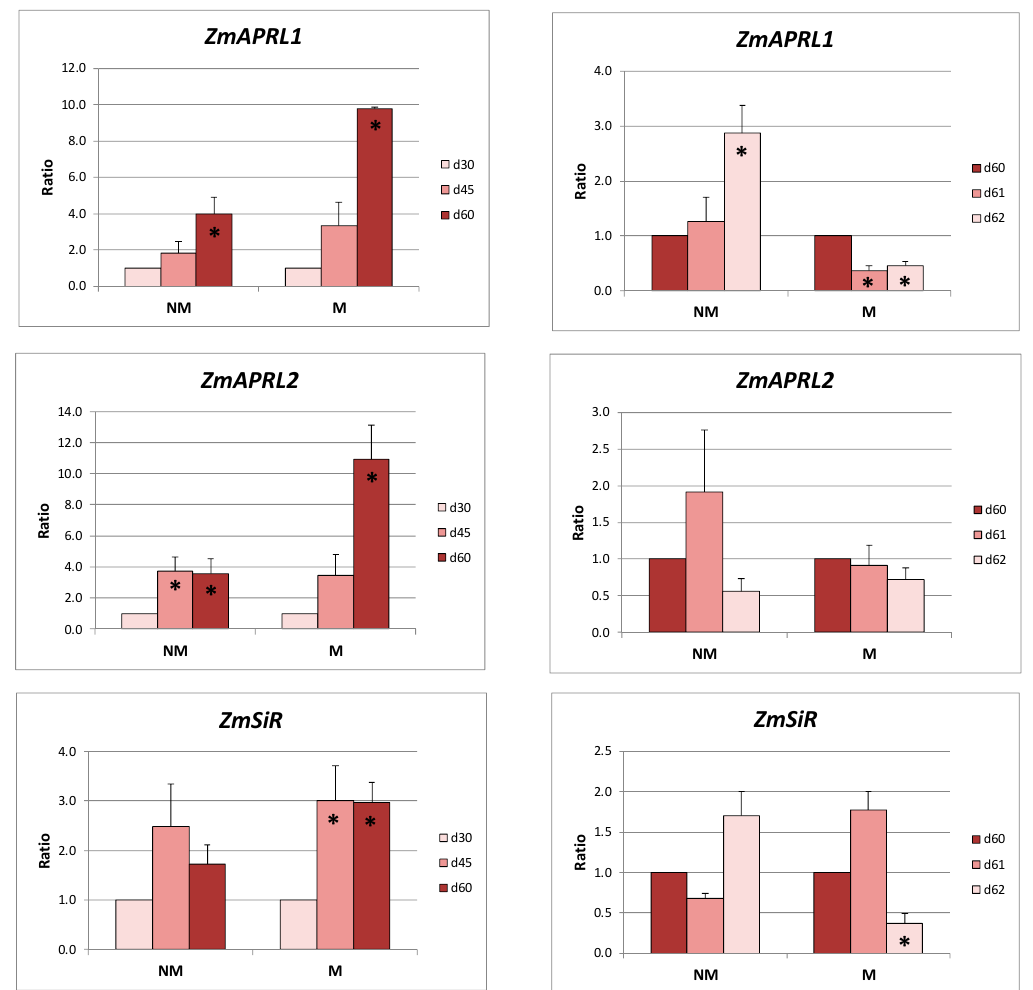
Figure 5. Relative expression ratios (the mean of six biological replicates ± SE) of ZmAPRIL1, ZmAPRL2 , and ZmSiR in the roots of non-mycorrhizal (NM) and mycorrhizal (M) maize plants before (left column) and after (right column) the supply of sulfate. d30 / d45 / d60 / d61 / d62: days after sowing. Significant differences ( p < 0.05) between the samples and the respective controls are represented by an asterisk (*).